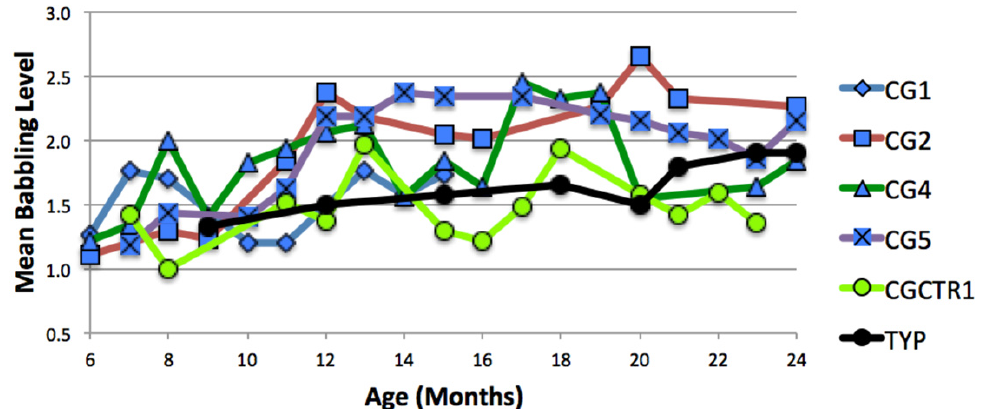
Figure 1. Mean Babbling Level (MBL) scores for the four children with CG in the treatment cohort (blue symbols), the control child with CG (green symbols), and typically developing children (black symbols, archival data from (Morris,